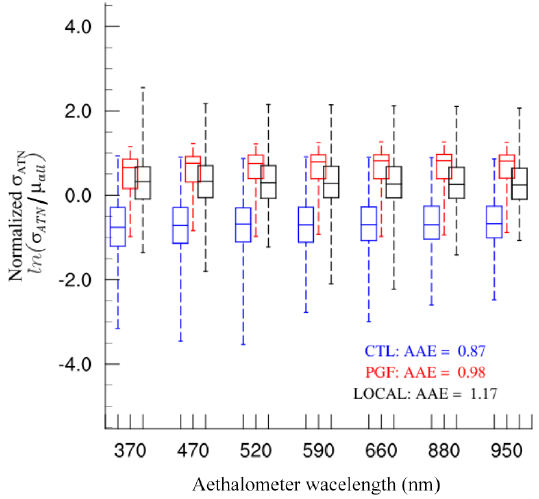
Figure 4. Normalized aethalometer light absorption coefficient at seven wavelengths for hourly periods classified as CTL (blue), PGF (red), and LOCAL (black). Upper/lower box bounds represent up- per/lower 25% values, respectively. Upper/lower whiskers repre- sent max/min values, respectively. Box middle represents median value. Also displayed are the AAE values found by regression dur- ing each period.